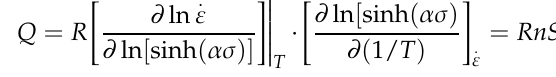
. ε Figure 7. ( a ) ln -ln[sinh( ασ )], ( b ) ln[sinh( ασ )]-1000 / T, and ( c ) ln Z -ln[sinh( ασ )] linear regression Figure 7. ( a ) ln ε  -ln[sinh( ασ )], ( b ) ln[sinh( ασ )]-1000/T, and ( c ) ln Z -ln[sinh( ασ )] linear regression relationship for the experimental relationship for the experimental alloy.